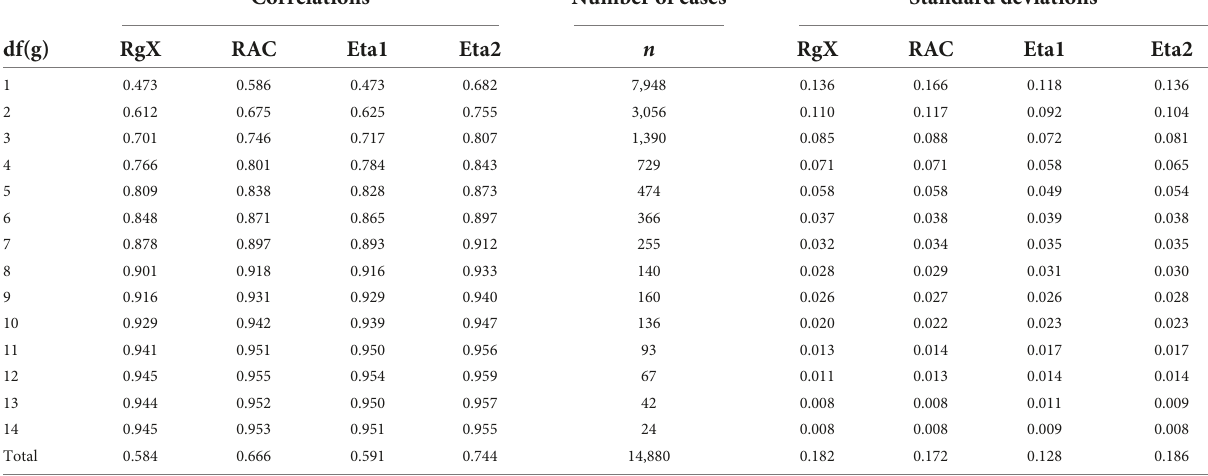
TABLE 6 Paired-samples t -test of the difference between PMC and RAC and Eta1.